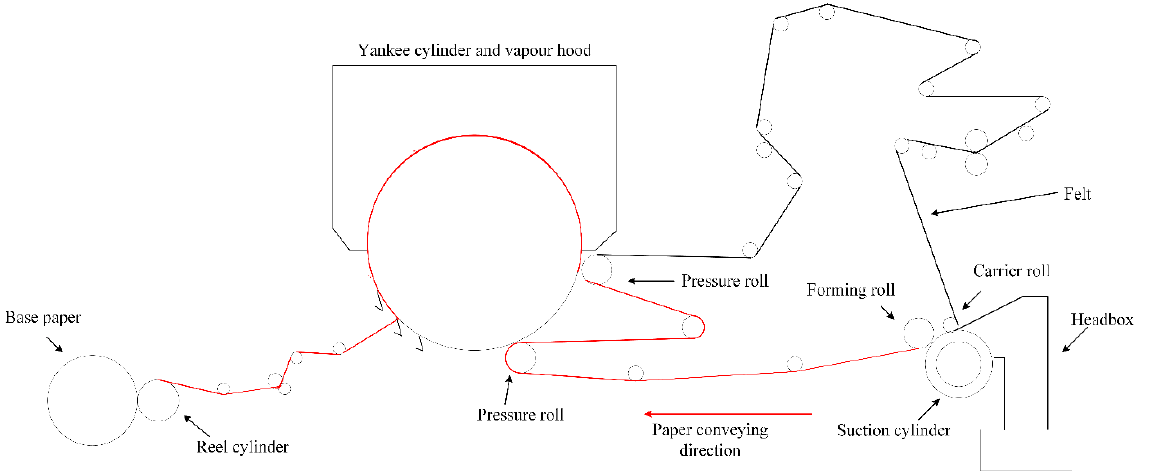
Figure 2. A typical cylinder paper machine.